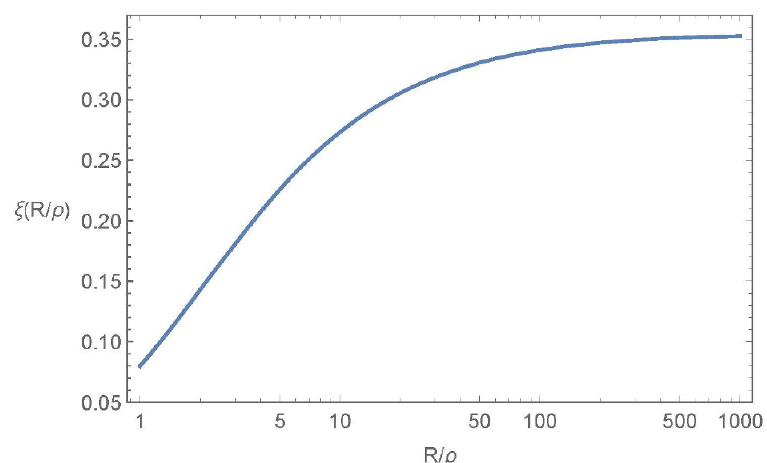
Figure 1 . (cid:24) as a function of R=(cid:26)